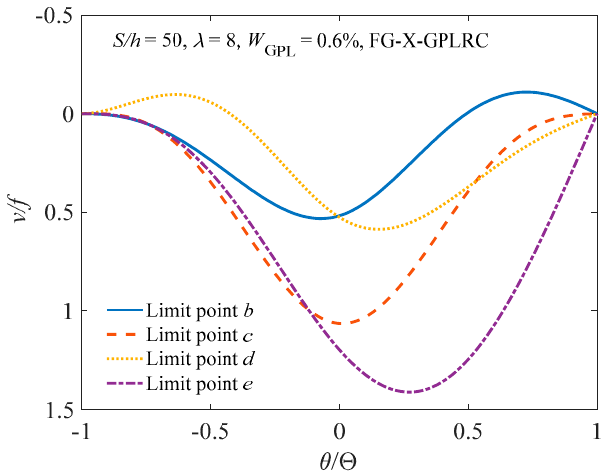
Figure 5. Distribution of dimensionless radial displacement along the arch length.